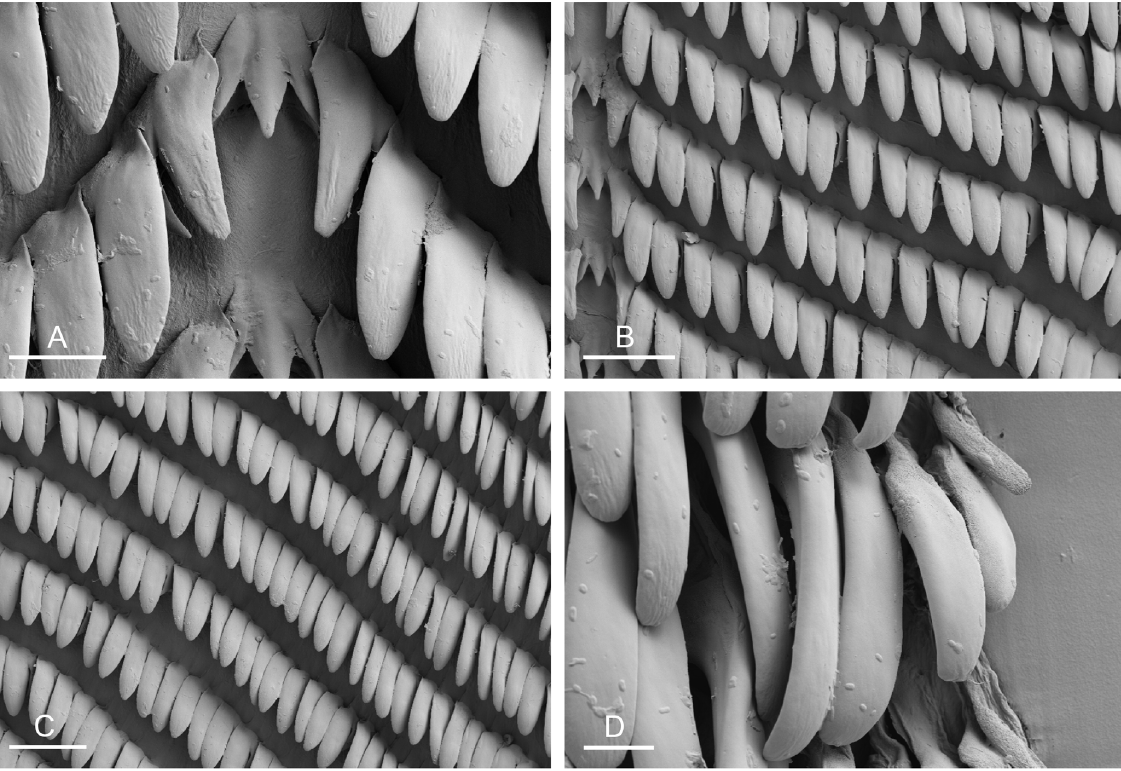
Fig. 49. Paromoionchis goslineri gen. et sp. nov. unit #1, radula, Philippines, Luzon [6049] (PNM 041272). A . Rachidian and innermost lateral teeth. B . Lateral teeth with rachidian teeth. C . Lateral teeth. D . Outermost lateral teeth. Scales: A = 20 μm; B–C = 50 μm; D = 10